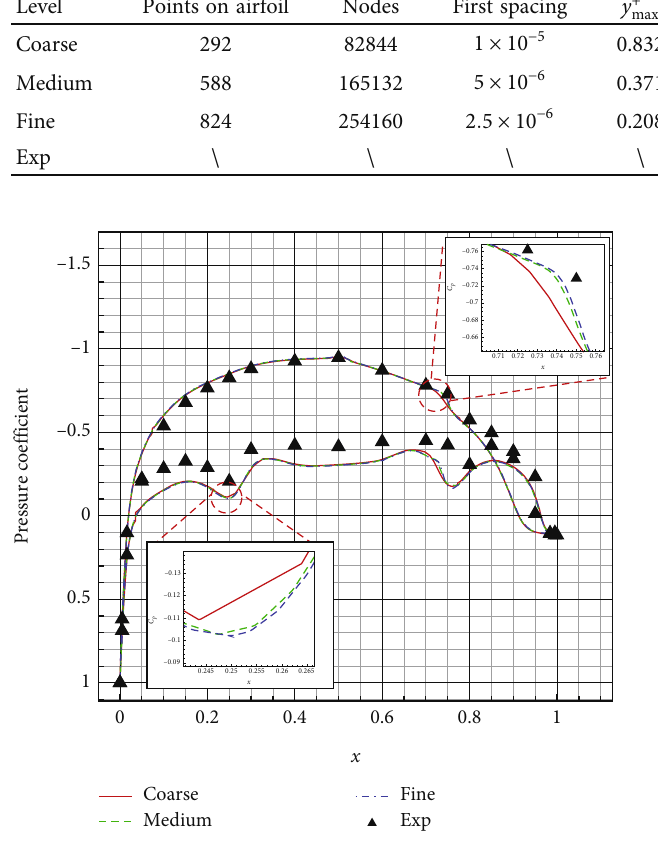
Figure 5: Pressure distribution ( Re = 1 : 4 E 6 , α = 2 °